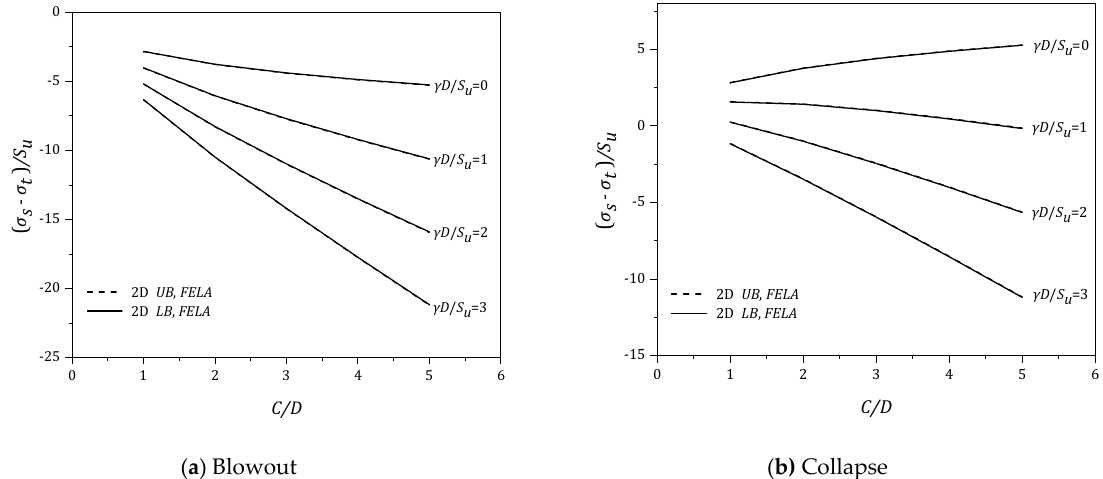
Figure 9. ( σ s − σ t )/ S u vs ( C/D ) for various ( γ D/S u ) − B/D = 0.75.